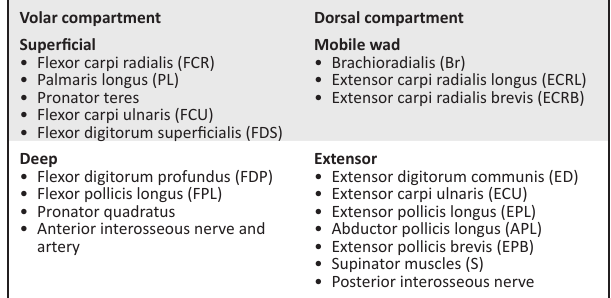
BOX 3: The anatomical divisions of the forearm compartments. 1